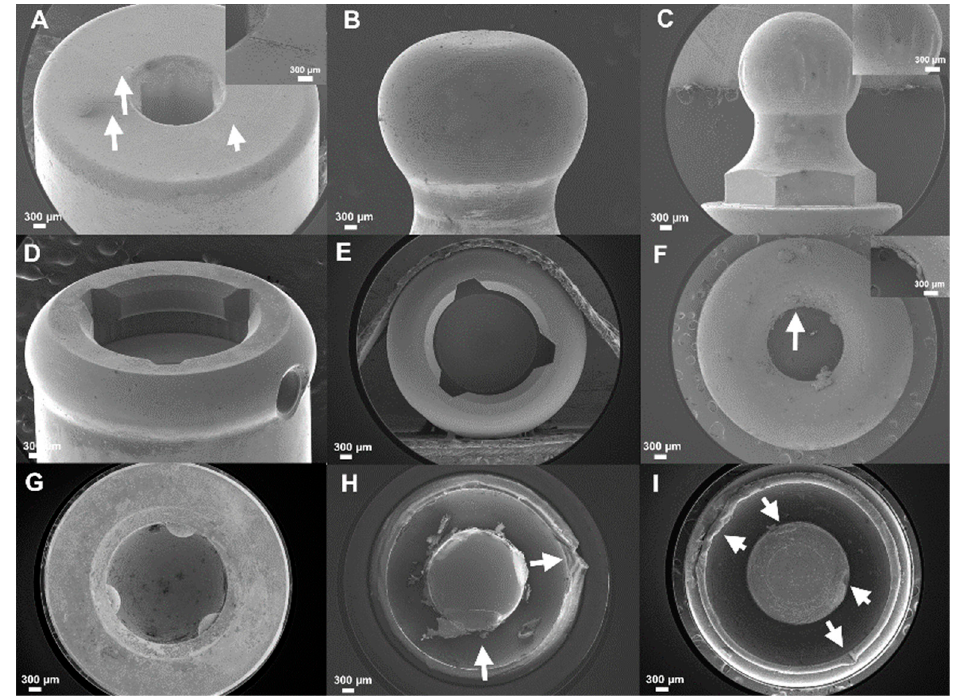
Figure 4. Field-emission scanning electron microscopy (FE-SEM) of the surface morphology of the attachments upon completion of 2250 insertion–removal cyclic loading. ( A ) MAG keeper, ( B ) ORI, ( C ) EZL, ( D ) LOC, ( E ) KER abutment, ( F ) ORI, ( G ) EZL, ( H ) LOC, and ( I ) KER replacement. Arrows indicate wear and deformed sites. Scale bar represents 300 µm.